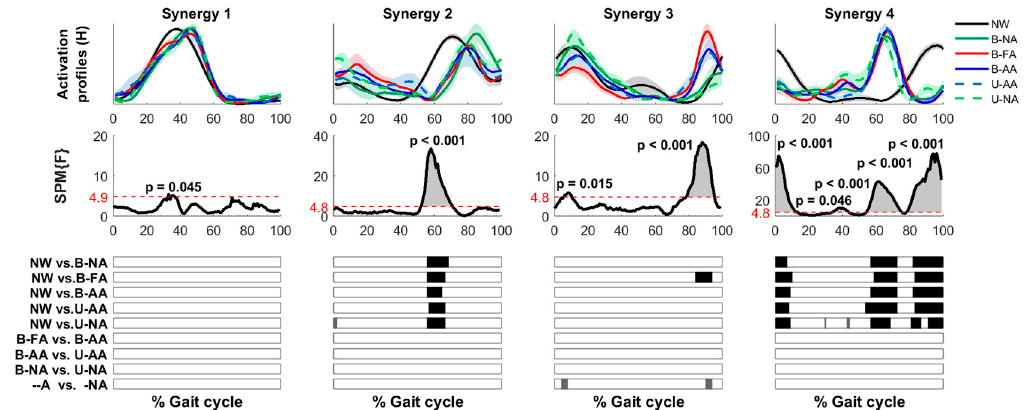
Figure 9. First row: Mean activation profiles of the four muscle synergies for all the walking conditions. Unilateral assistance is indicated with dashed lines, while bilateral assistance is indicated with continuous lines, and the type of assistance is indicated by the color of the lines: B-FA (red), B-AA, U-AA (blue), B-NA, U-NA (green). Second row: SPM{F} statistic as a function of the percentage of gait cycle. The threshold for significance is indicated in red. Third row: Statistic results for the pre-planned comparisons between normal walking and the five Ekso-assisted modalities (NW vs. B-NA; NW vs B-FA; NW vs. B-AA; NW vs. U-AA; NW vs. U-NA ) and for the comparisons between Ekso-assisted modalities (B-FA vs. B-AA; B-AA vs. U-AA; B-NA vs. U-NA; –A vs. -NA). Black intervals p < 0.001 and grey intervals p < 0.05.